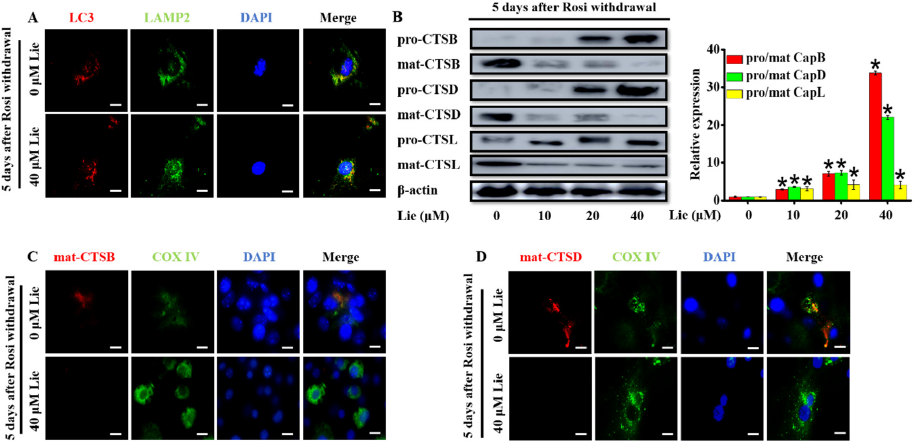
Figure 3. Lie blocked mitophagy flux by impairing the function of lysosomal proteases after Rosi withdrawal in vitro. After Rosi withdrawal, beige adipocytes were subjected to Lie for 5 days. ( A ) Fusion between autophagosomes (anti-LC3) and lysosomes (anti- lysosome-associated membrane protein 2) (anti-LAMP2) was evident in Lie (0 and 40 µ M)-treated beige adipocytes (yellow in merged images). Scale bars, 20 mm. Western blot analysis showing the levels of